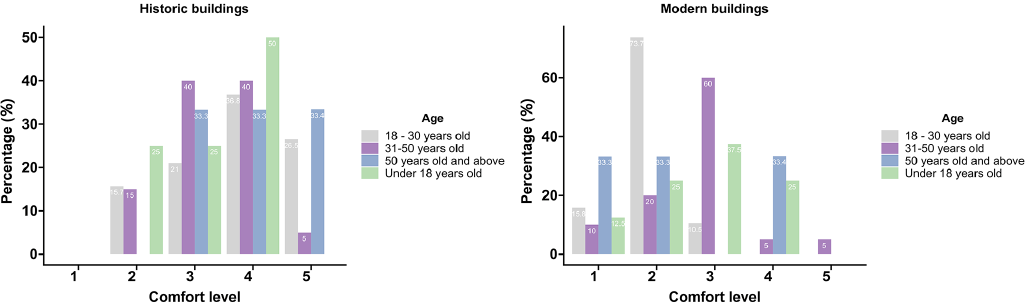
Figure 6. Percentage of evaluation levels by age groups.